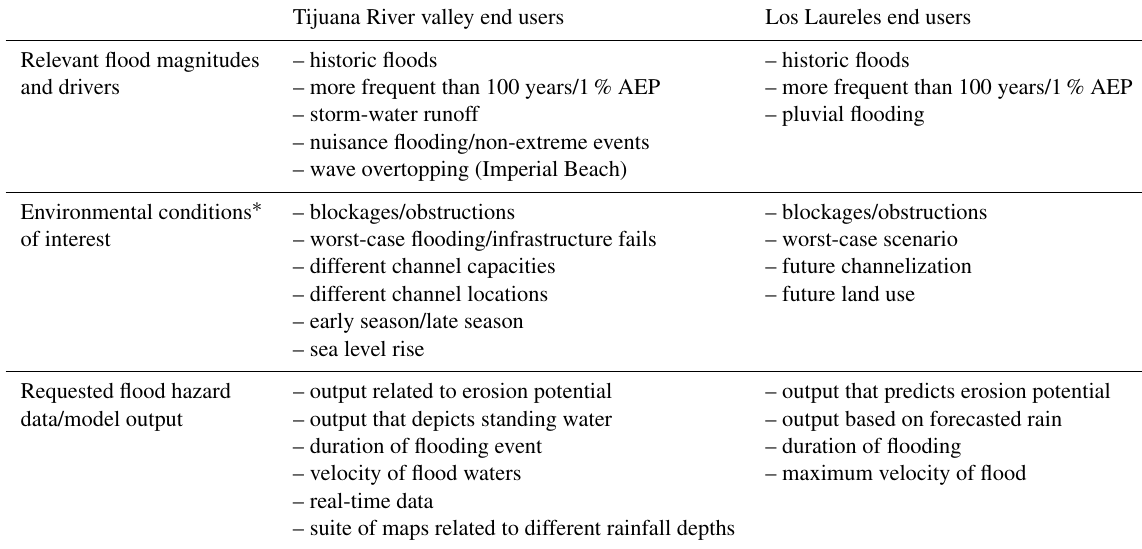
Table 2. Summary of information used to re-run the hydraulic models and produce new hazard maps (requested map scenarios). These specific requests were identified through transcript content